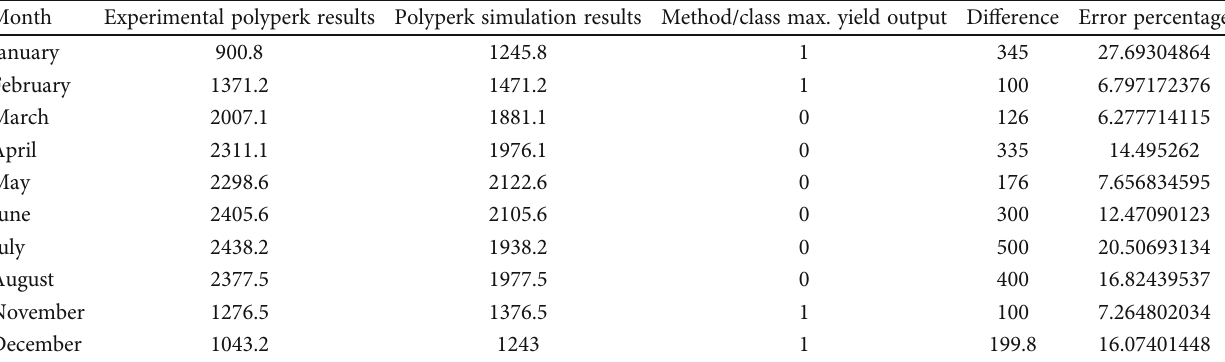
Table 7: Data set of polyperk crystalline module in simulation and experimental